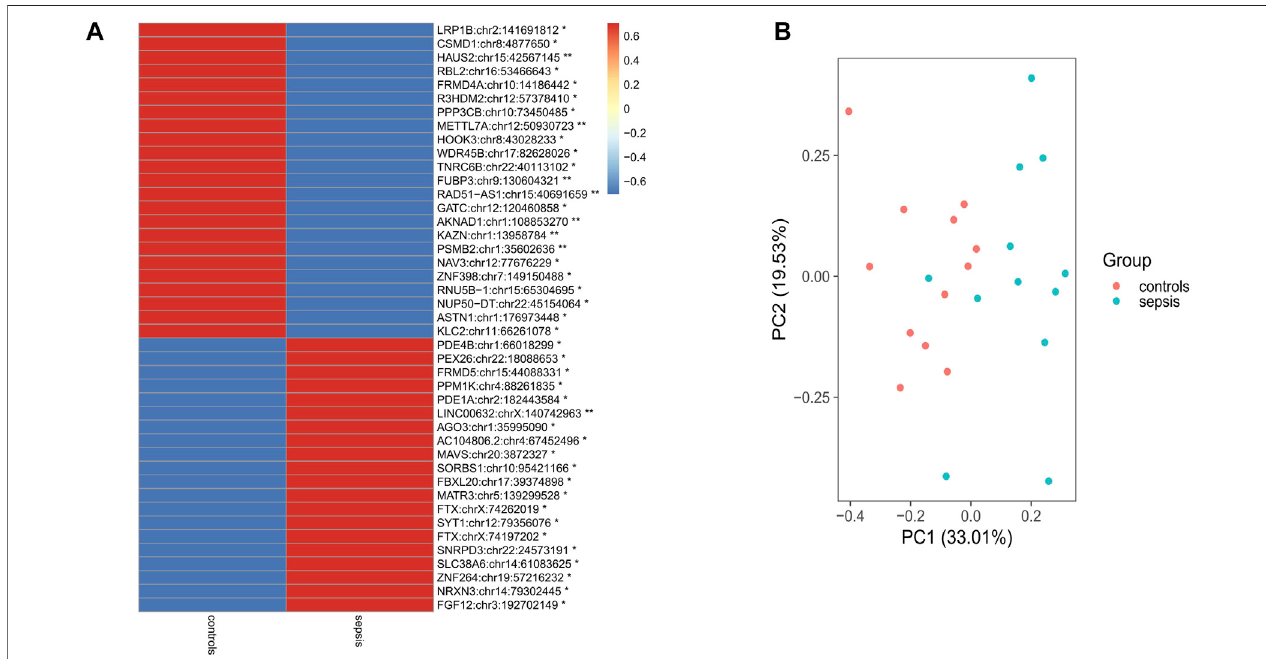
FIGURE 2| Differential RNA editing sites in the brain between sepsis and controls. (A) 43 sites that show statistically different editing levels. *: p < 0.05; **: p < 0.01; p -values are calculated using the Student ’ s-test. (B) Principal component analysis of the 43 differential editing sites between sepsis and controls.